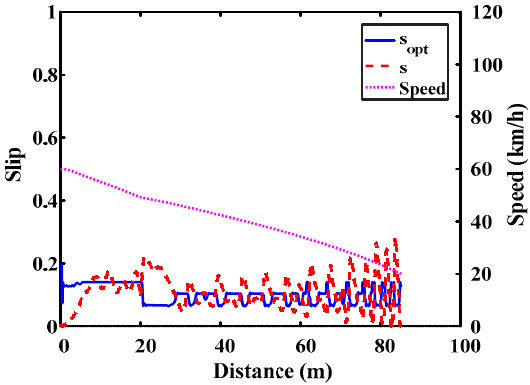
Figure 12. Optimum slip, real slip and speed.